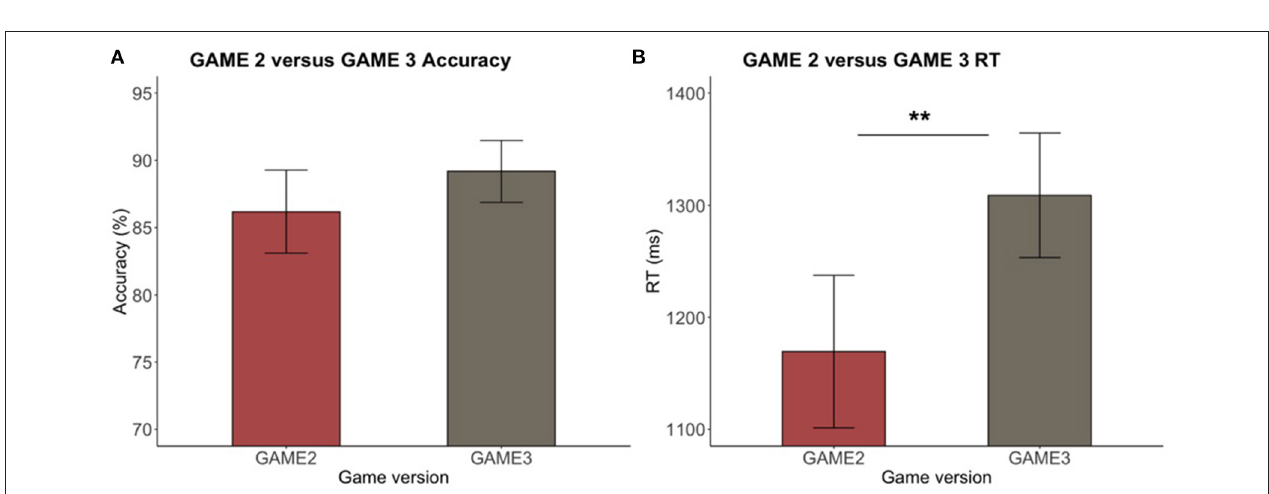
FIGURE 8 | Experiment 3: Experiment vs. game accuracy and RT. The bar chart indicates (A) the mean accuracy and (B) the mean RTs across participants, while the error bars show the 95% confidence intervals. No significant difference was found in accuracy or RT between versions.